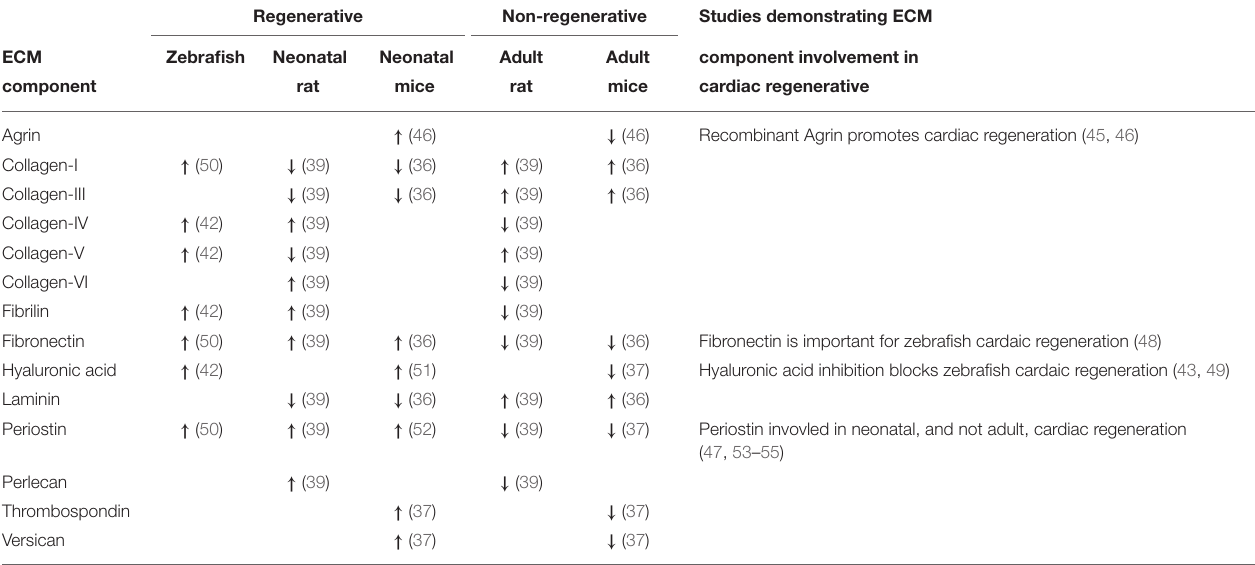
TABLE 1 | Differential Expression of extracellular matrix (ECM) components in regenerative vs. non-regenerative hearts in different species. Regenerative Non-regenerative Studies demonstrating ECM Zebrafish Neonatal Neonatal Adult Adult component involvement